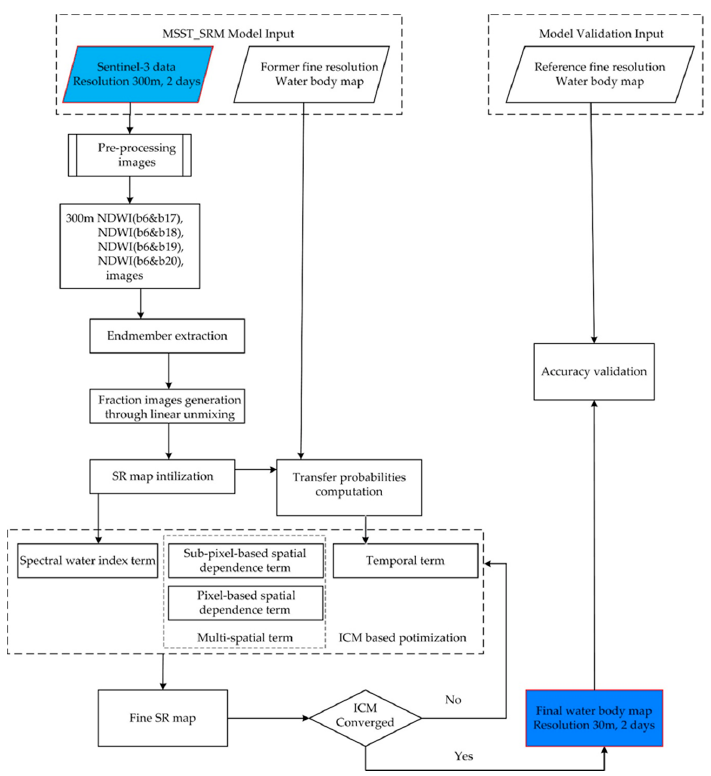
Figure 1. Flowchart of the multiscale spatial–temporal super-resolution mapping (MSST_SRM) approach.